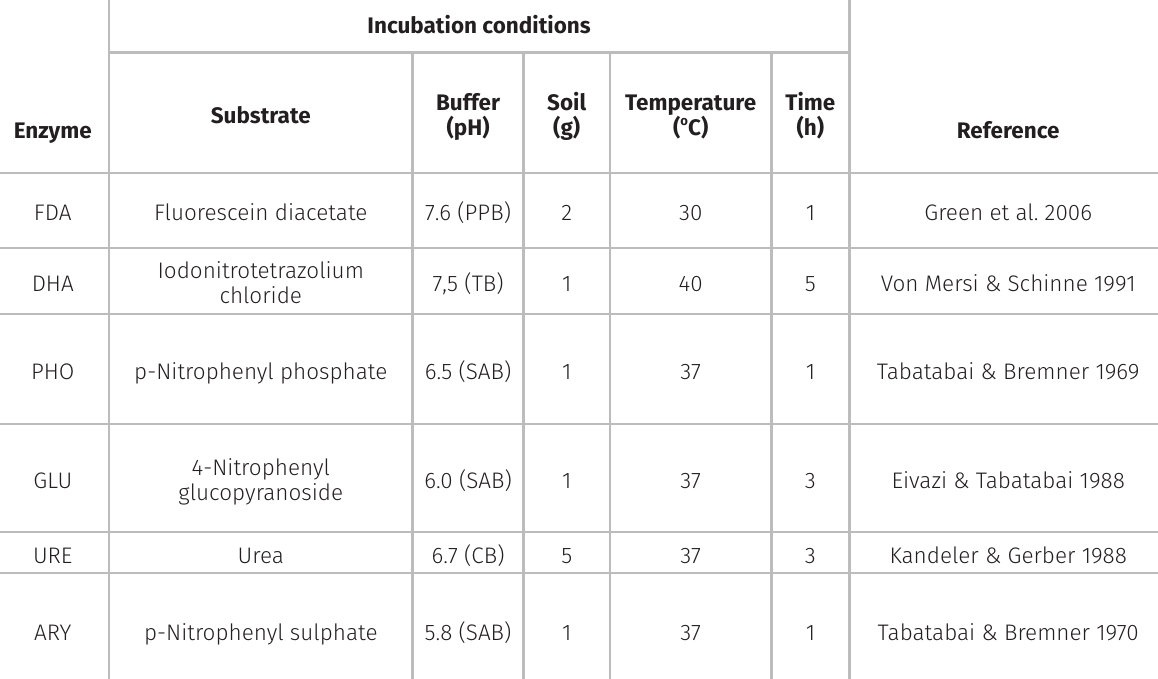
Table III. Incubation conditions of enzymes used with biochemical indicators.